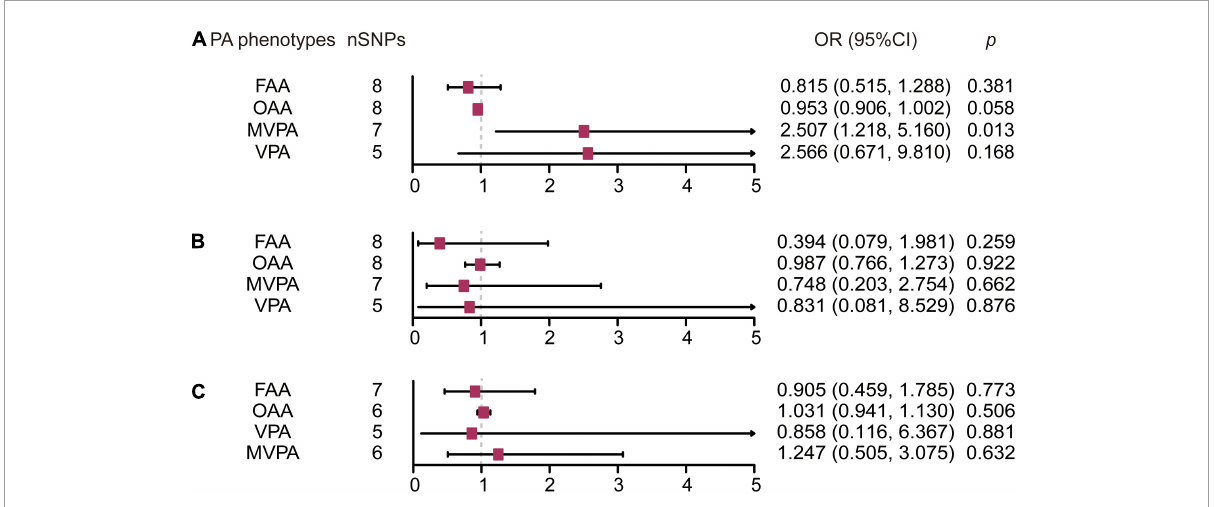
FIGURE3 Forest plot of causal effect of physical activity phenotypes on amyotrophic lateral sclerosis (A) , Parkinson’s disease (B) , and Alzheimer’s disease (C) estimated by the inverse variance weighted method. PA, physical activity; SNP, single nucleotide polymorphism; MVPA, Self-reported moderate-to-vigorous physical activity; VPA, Self-reported vigorous physical activity; OAA, Overall acceleration average; FAA, Fraction of accelerations > 425 milli-gravities; OR, odds ratio; CI, confidence